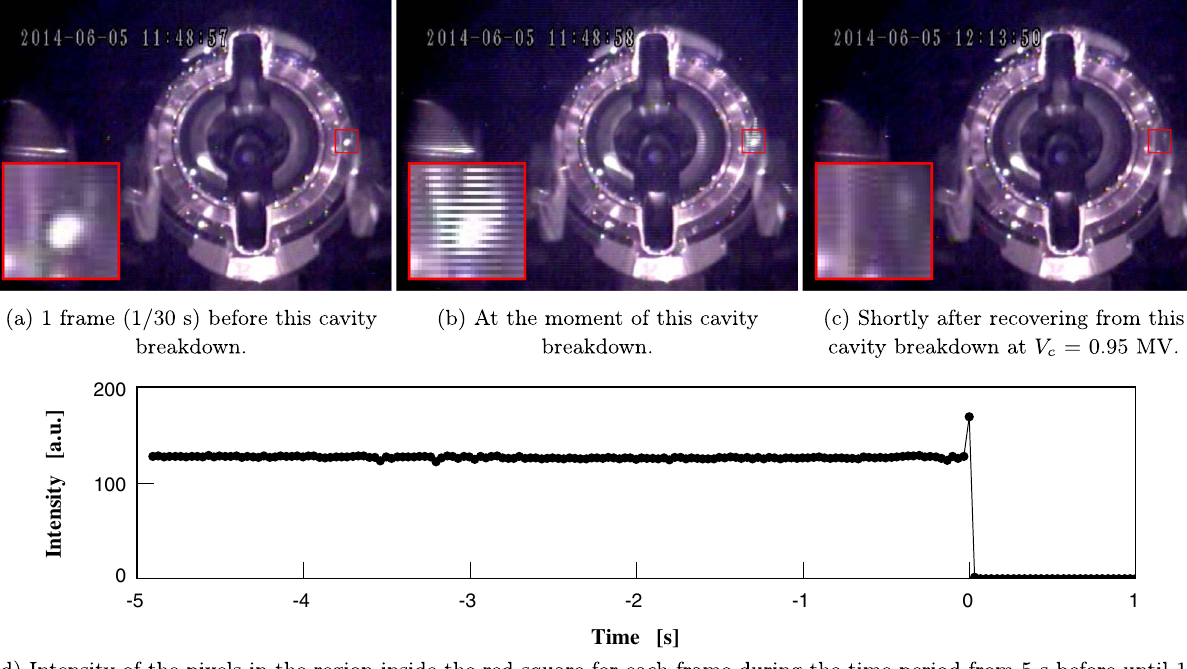
FIG. 9. Example of spot-type explosion events with a stable bright spot. (a), (b), and (c) are snapshots, in chronological order, of the FEP recorded with TV camera 3 during the rf conditioning. The insets are magnified views of the region outlined by a red square. The bright spot at 3 o ’ clock [inside the red square in (a)] exploded at V c ¼ 0 . 95 MV, as shown in (b), and then disappeared, as shown in (c). A clear spike was observed in the intensity of the region outlined by a red square at the moment of this cavity breakdown, as shown in